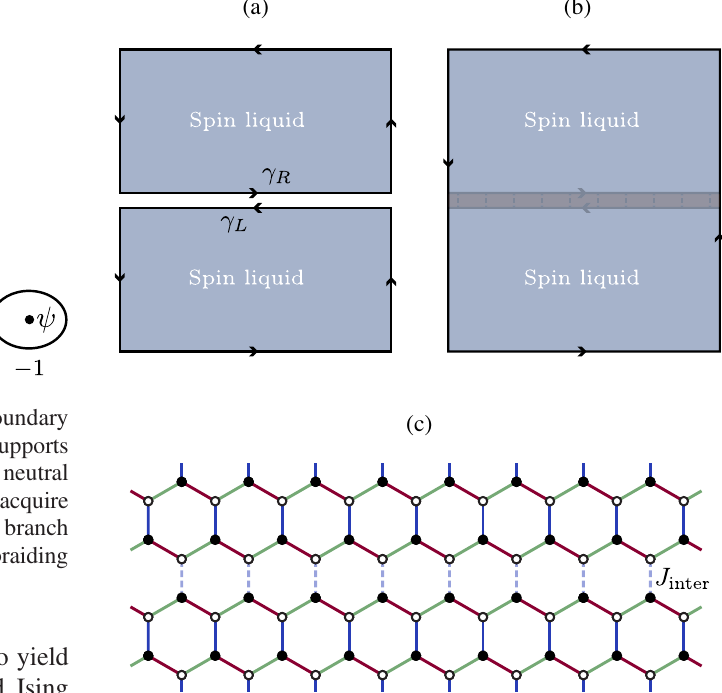
FIG. 3. (a) Decoupled non-Abelian spin liquids hosting emer- gent chiral Majorana fermions γ and γ at their interface. R L (b) Strong interactions between γ and γ [described by R L Eq. (17) with κ > 0 ] gaps out these modes — thus sewing the two phases into a single non-Abelian spin liquid. (c) Microscopic view of the spin-liquid interface viewed as two Kitaev honey- > 0 comb models coupled via vertical bonds of strength J inter (dashed lines); see Eq. (19). The interface is fully gapped, as in (b), when J exceeds a critical value J , but otherwise hosts c inter gapless Majorana modes, as in